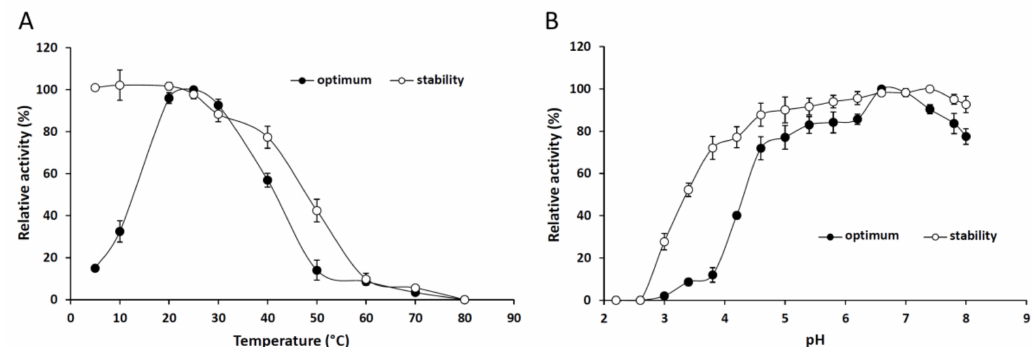
Figure 2. Effect of the temperature ( A ) and pH ( B ) on the activity and stability of the purified M. echinosphaera CBS 575.75 lipase. To determine the optimum temperature, p NPP-hydrolyzing activity was measured in a temperature range of 5–80 ◦ C in phosphate buffer (50 mM, pH 6.8) for 30